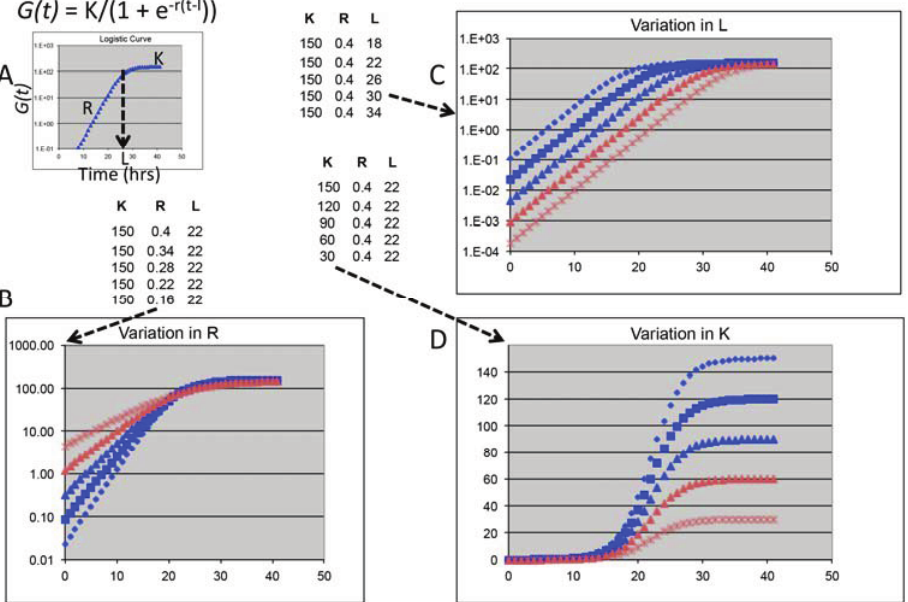
Figure 1. Cell proliferation parameters (CPPs) for quantifying gene interaction are obtained from fitting Q-HTCP data with a logistic growth function. The equation and an example growth curve are shown in panel A; CPPs are phenotypes for measuring gene interaction: K is the carrying capacity (final growth density, quantified as average pixel intensity), L is the time (h) it takes for a culture to reach K/2, and R is the maximum specific rate. Each parameter is independent of the other, because G(0) is treated as unknown. The CPPs for each graph are given in the respective table to illustrate variation in each